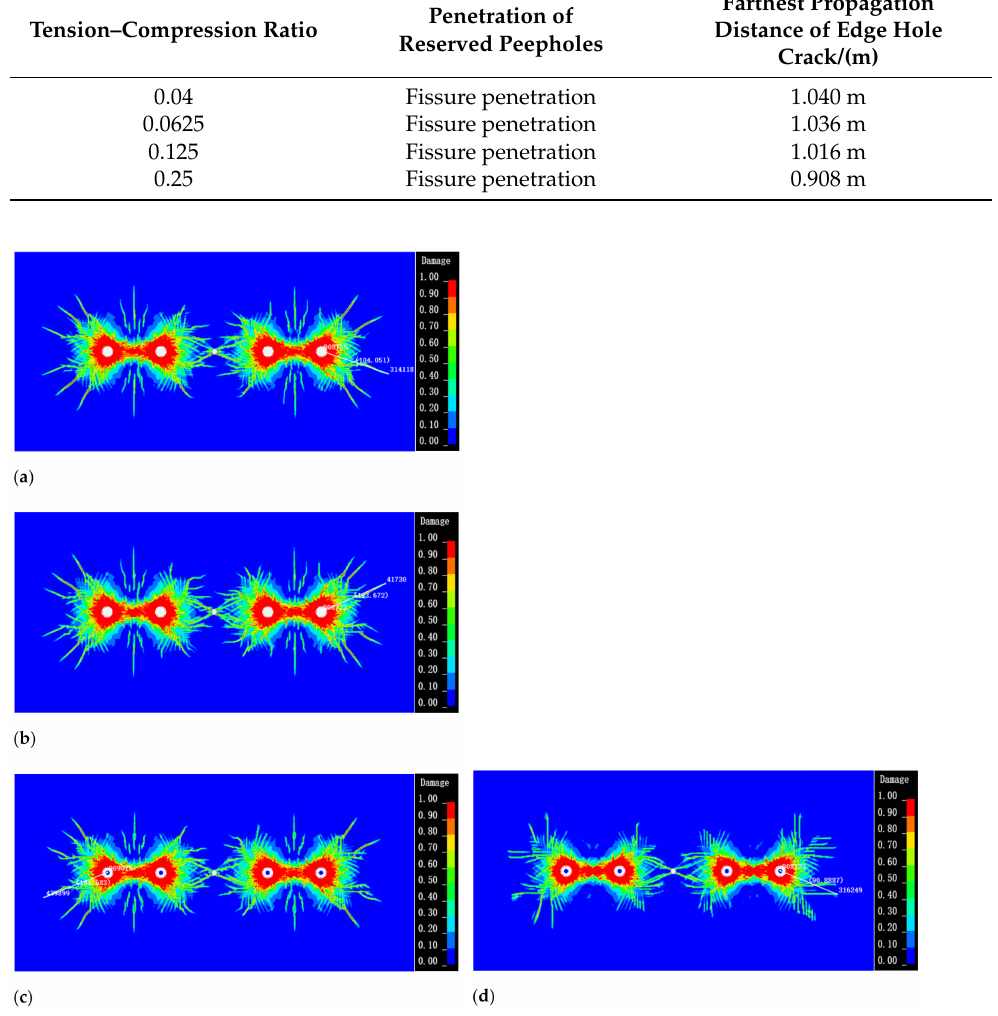
Figure 10. Evolution and distribution characteristics of cracks between blasting roof cutting holes under different tension–pressure ratios. ( a ) Tension compression ratio 0.04. ( b ) Tension compression ratio 0.0625. ( c ) Tension compression ratio 0.125. ( d ) Tension compression ratio